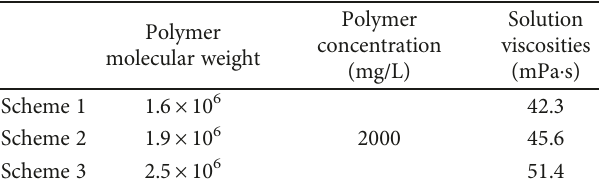
Table 2: Viscosity of ASP solution.